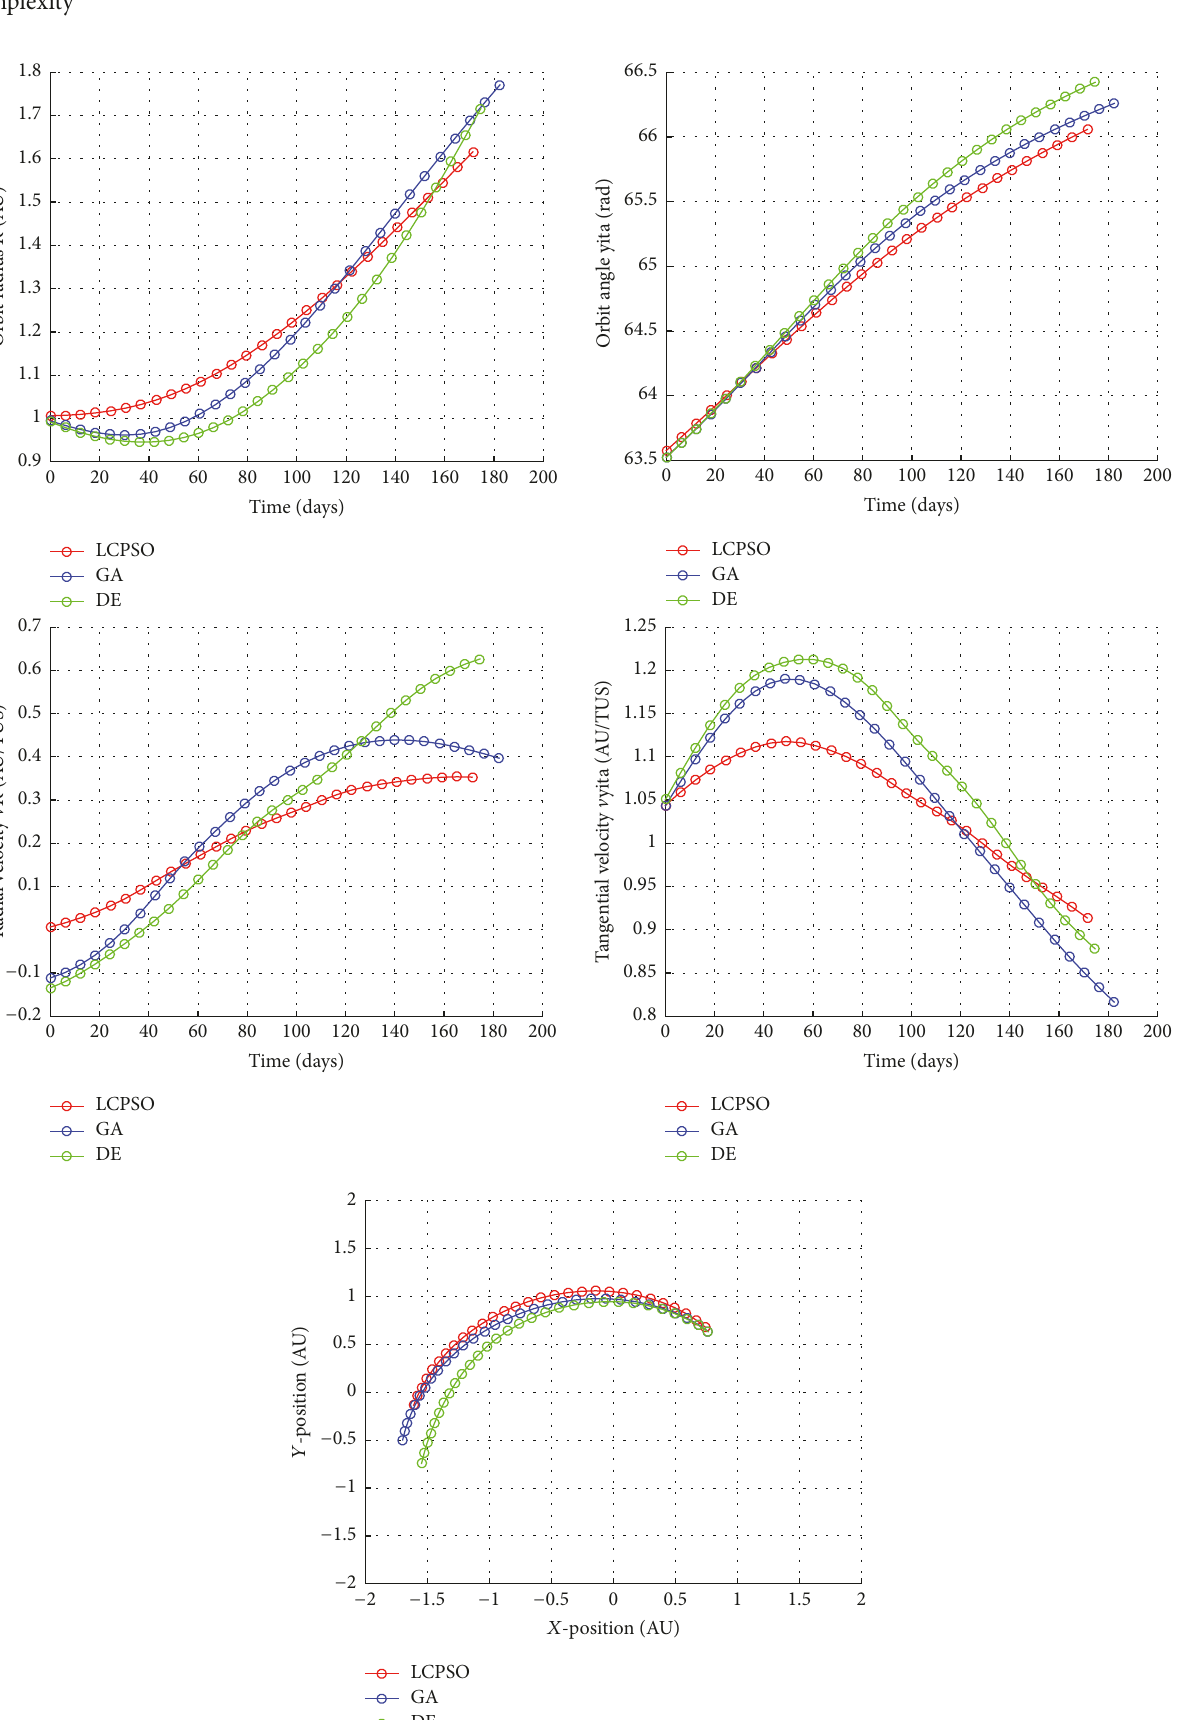
Figure 8: State variables in heliocentric